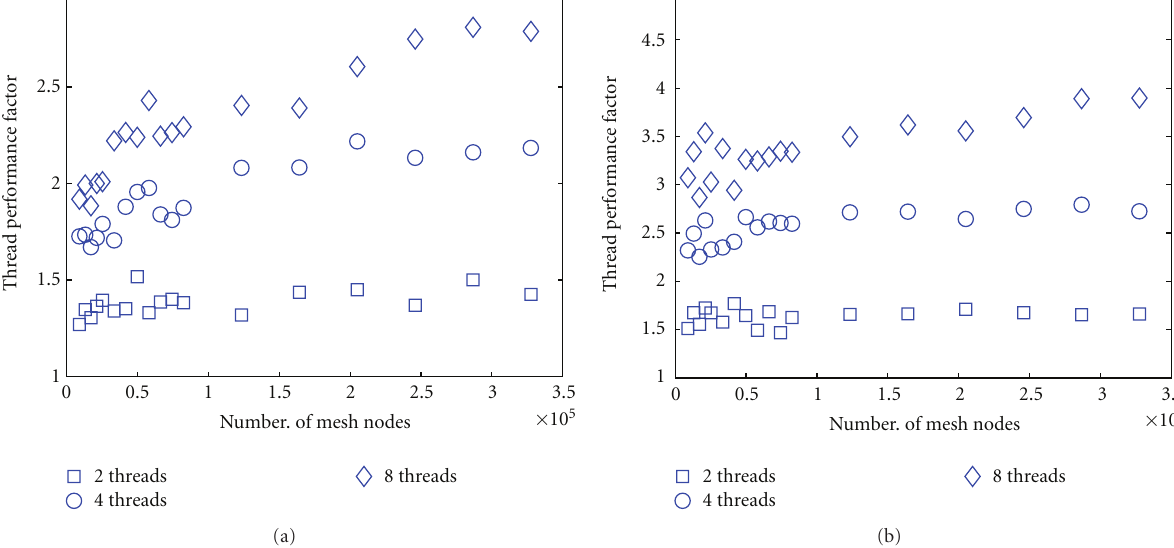
× 10 5 Number. of mesh nodes